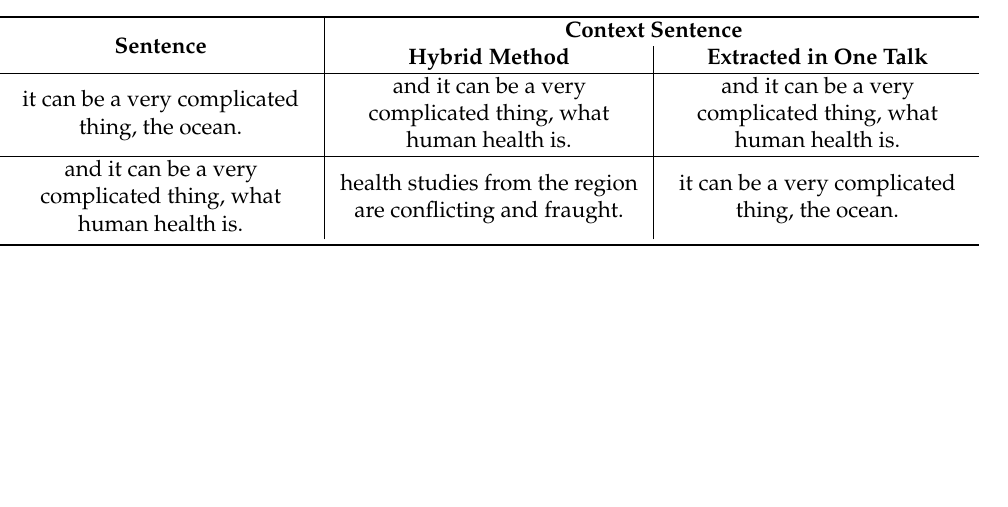
Table 8. Examples of four sentences extracted using the hybrid